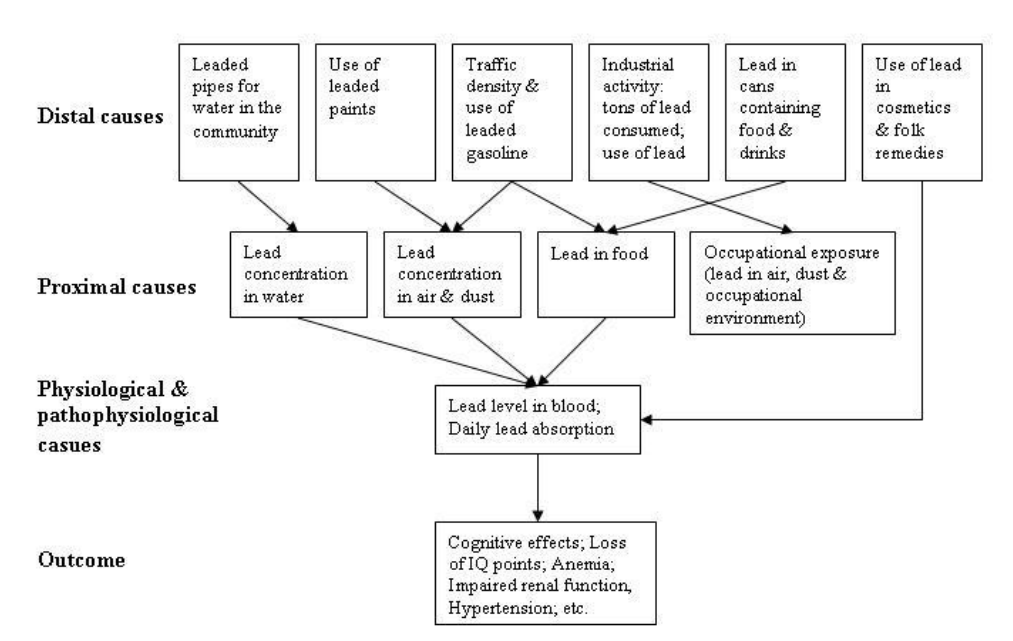
Figure 3. Causal web for chronic exposure to lead (reproduced with permission from [44], published by WHO, 2000). A causal web is a hierarchical cause-to-effect framework, categorizing three levels of risk factors: distal, proximal, and direct (physiological) causes. Distal causes operate through proximal, then direct causes on disease